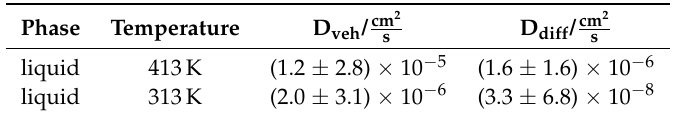
Table 1. Computed diffusion coefficients via the root mean square displacement based on our ab-initio molecular dynamics trajectories for both liquid phases. D veh denotes the center of mass-based diffusion coefficient of triazole molecules and D diff denotes the independent movement of the acidic hydrogen. The latter has been calculated by using the relative coordinate of the acidic hydrogen with respect to center of mass of the triazole molecule it originally was bond to. The error bars represent the statistical variance obtained from the ensemble of